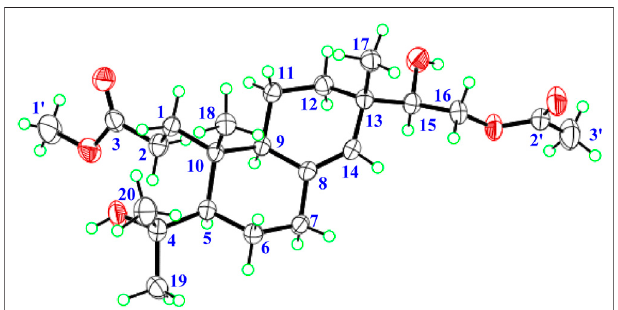
FIGURE 3 | X-ray crystallographic of